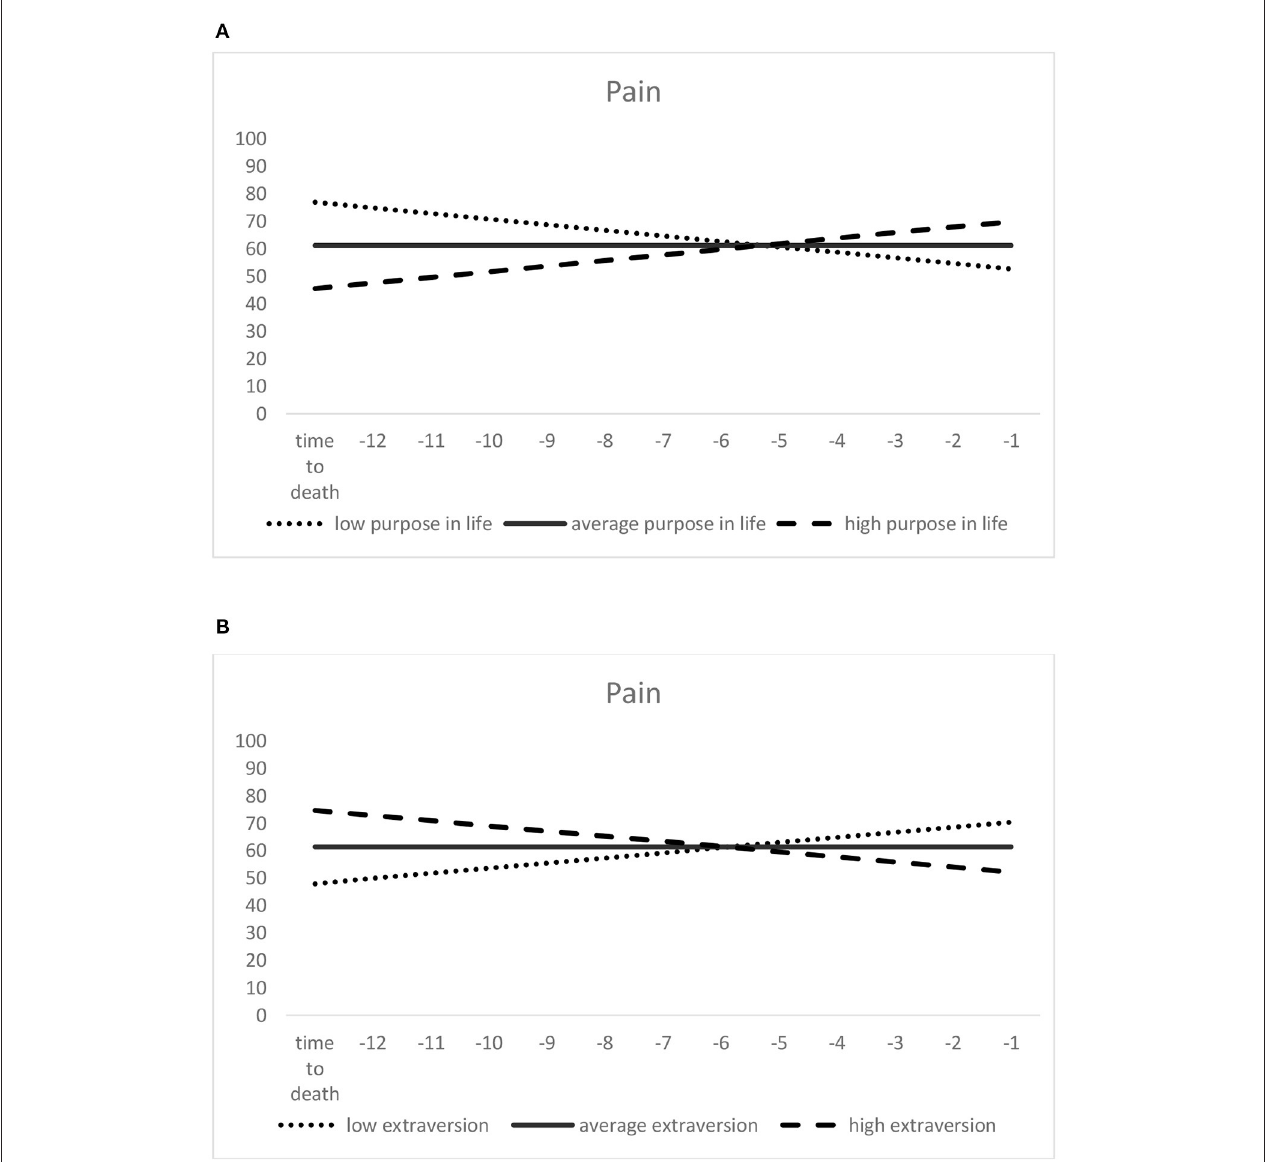
FIGURE 3 | Predictors of time-to-death-related pain trajectories: purpose in life (A) and extraversion (B) . Higher scores indicate lower pain. Low ( = one standard deviation below the mean), average ( = sample mean score), and high ( = one standard deviation above the mean) purpose in life/extraversion were derived from the scores assessed at the first measurement